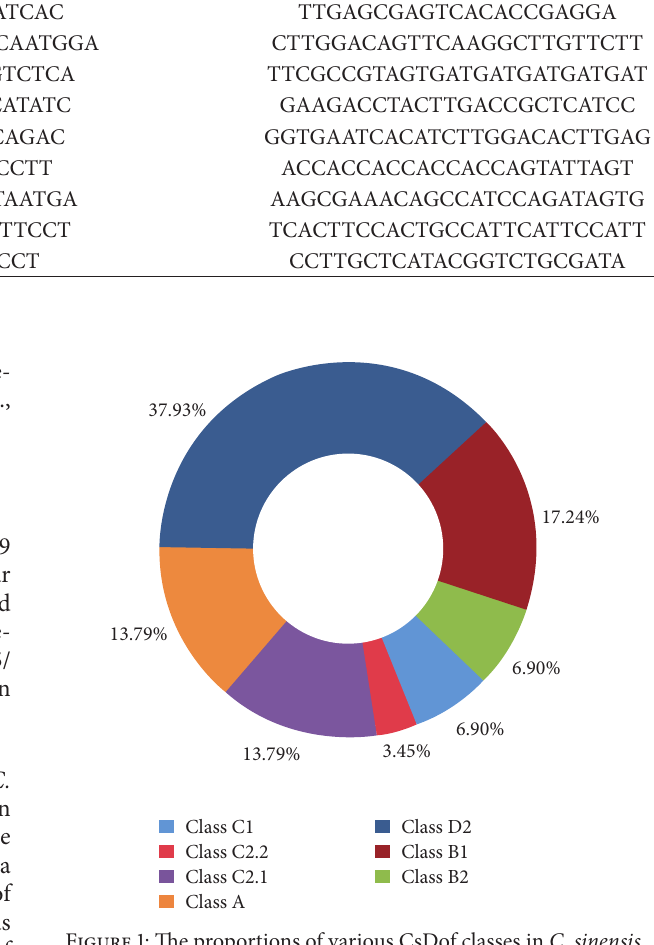
proteins had various confidence levels, a total of 13 CsDof family proteins had nonspecific hits, and 16 CsDof family proteins had specific